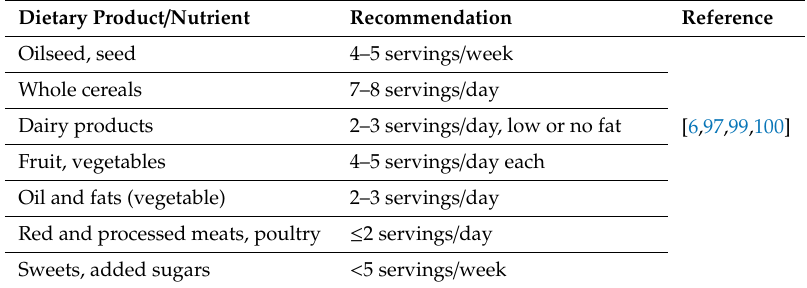
Table 3. Dietary recommendations according to the Dietary approaches to stop hypertension (DASH)